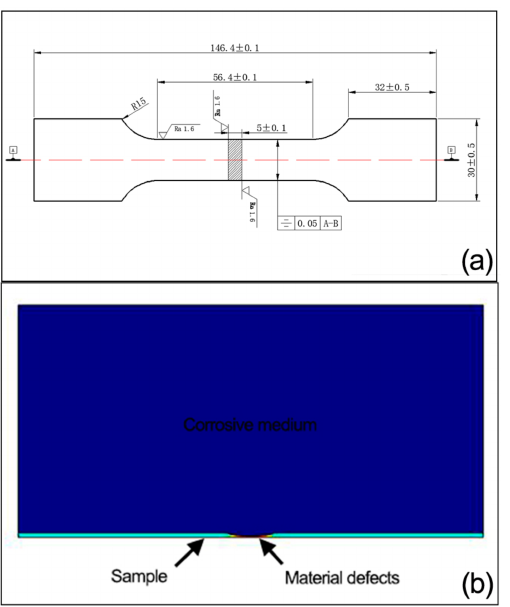
Figure 10. The geometrical model of the steel pipe containing a corrosion defect for simulation ( a ) 3D model ( b ) 2D